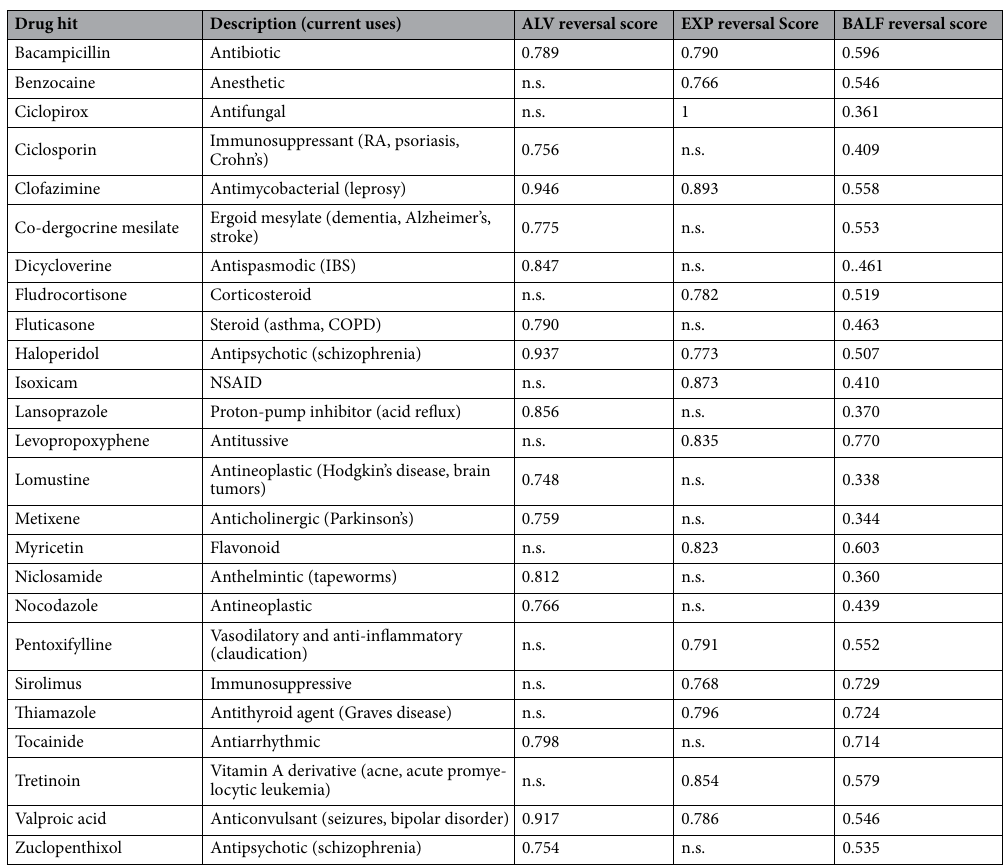
Table 1. Therapeutic hits reversing at least 2 of input SARS-CoV-2 signatures. A wide variety of drugs were identified by the analysis of multiple signatures. Drug reversal scores are normalized for each signature; drug entries marked “n.s.” were not significant for reversing that